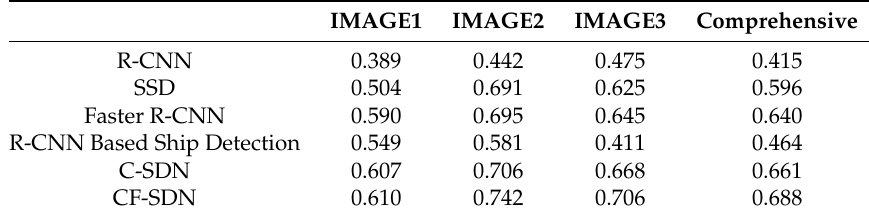
Table 3. Performance comparison of the six methods on the testing set in terms of AP.